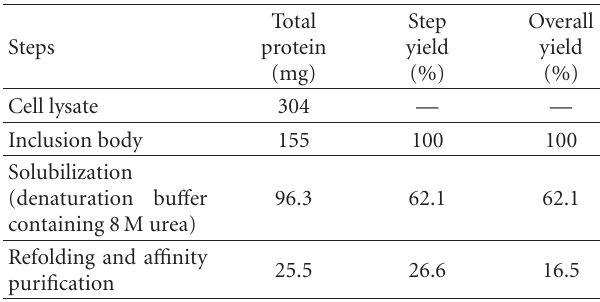
Table 1: Purification of chimeric protein VEGI-CTT from inclu- sion bodies (from 1L of E. coli culture and 4.6g wet weight cells).